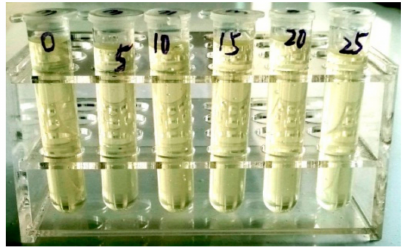
Figure 3. Appearance of PAA / TSP composite varnishes with the labeled weight percent of